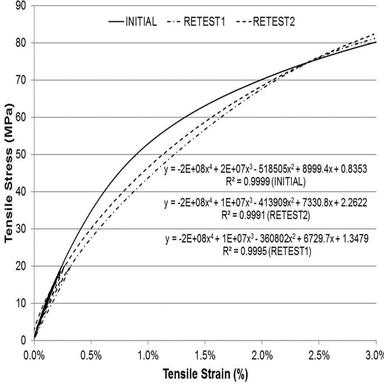
Modelling of loading curves with quartic equations for the initial, retest and self-healed retest stages.